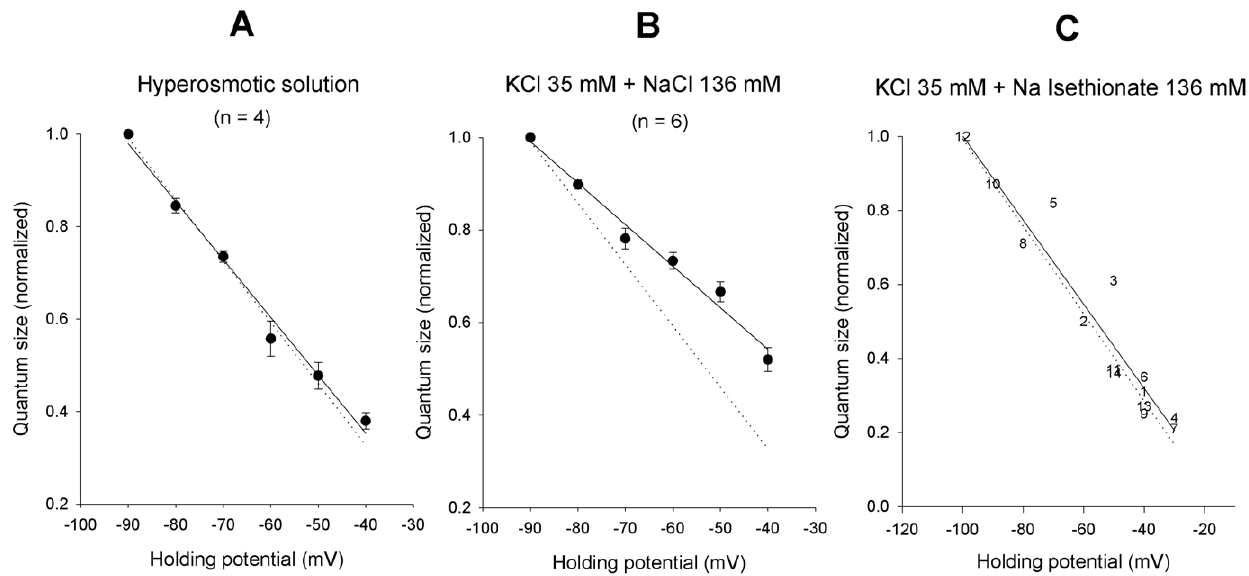
Figure 5. mEPSP I–V curves are influenced by the impermeant chloride ion. ( A ). I–V relationship of mEPSPs recorded, under two-electrode current clamp conditions at different holding potentials in the 2 40/ 2 90 mV range, in 4 neurons exposed to an external solution made hyperosmotic (718 mosmol/kg) with 0.37 M sucrose. Quantum size was calculated in the different tracings as described in Figure 4B and C, and normalized to the value measured at 2 90 mV ( 2 90 mV mean value =1.6 6 0.2 mV). The I–V curve of EPSPs (continuous line) was virtually superimposable to the normalized I–V curve of control EPSCs (dotted line; same data, normalized, as in Figure 1B). Hypertonicity does not seem to affect the I–V relation. ( B ). mEPSP I–V relationship (continuous line) evaluated as in ( A ) in a 6-neuron sample exposed to enriched K + solution ( 2 90 mV quantum size =1.3 6 0.3 mV). Control EPSC I–V relationship is shown as in ( A ) (dotted line), for comparison. The different slope of the curves points to a rightward shift of the null potential in high [K + ] e . ( C ). I–V relationship of quantal events recorded in a single neuron at different holding levels while exposed to a